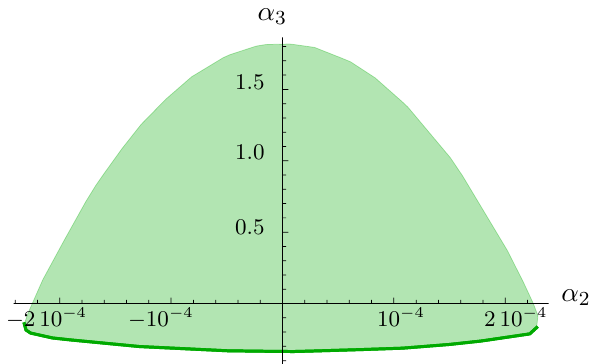
Figure 3. Region within the two-dimensional parameter space ( (cid:11) 2 ; (cid:11) 3 ) describing regular devi- ations around the N = 0 , SU(3) vacuum of table 1 with potential V = (cid:0) 23 : 413628 in the IR.